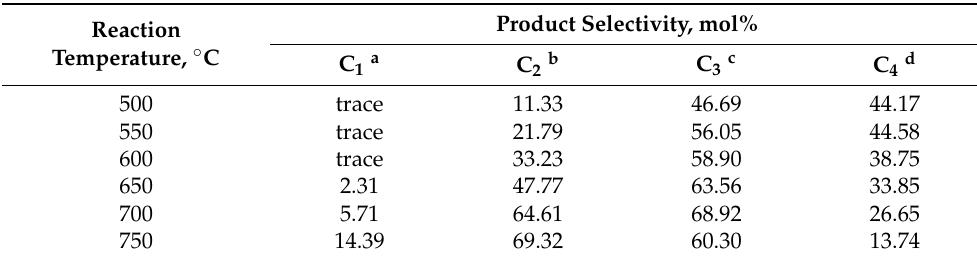
Table 2. Selectivities of the main product from pentene catalytic cracking under various